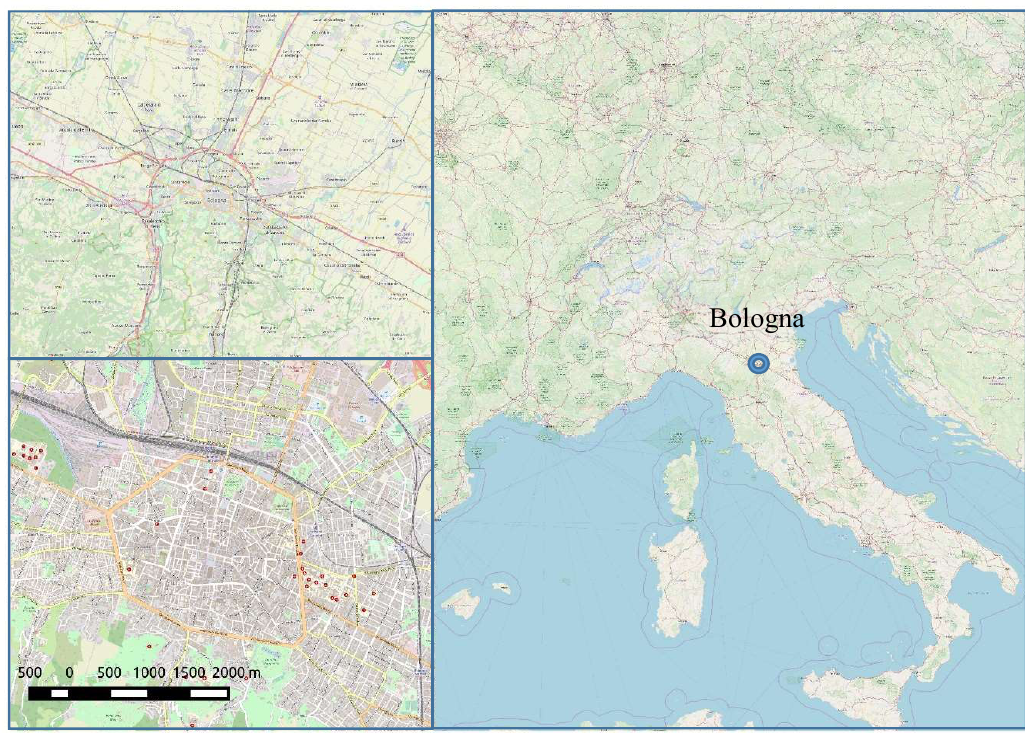
Figure 1. Bologna location in the Italian contest.